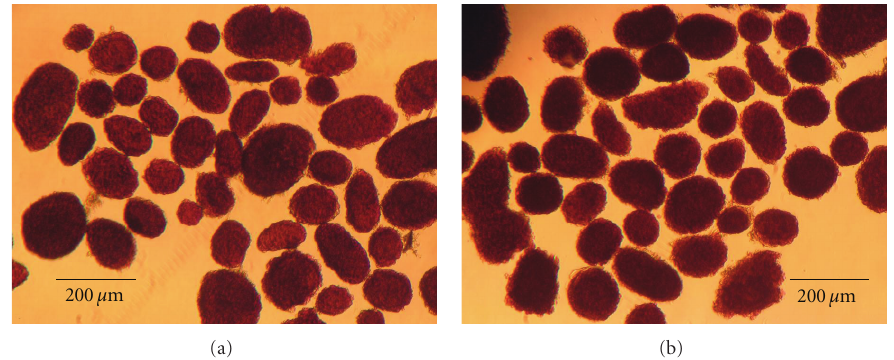
Figure 2: Normal mouse pancreatic islets after collagenase digestion and Ficoll separation with further purification by handpicking. Islets were stained with dithizone (red). The left panel shows islets isolated with BSA; the right panel shows islets isolated without BSA. Close to 100% purity may be achieved with this method. Scale bar indicates size in